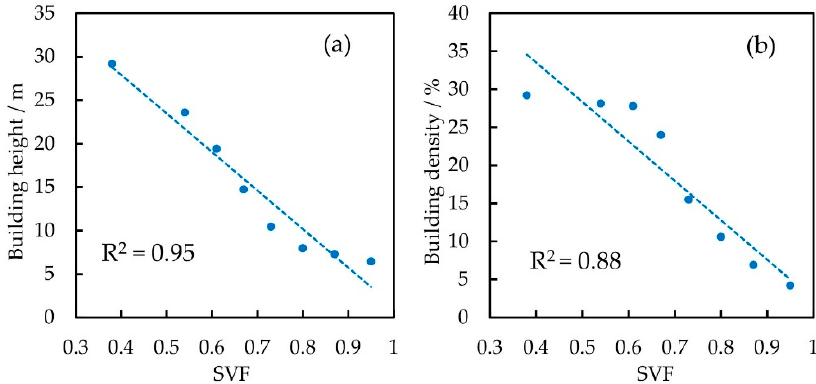
Figure 4. Relationship between the SVF and building indicators: ( a ) relationship between the SVF and building height; ( b ) relationship between the SVF and building density.